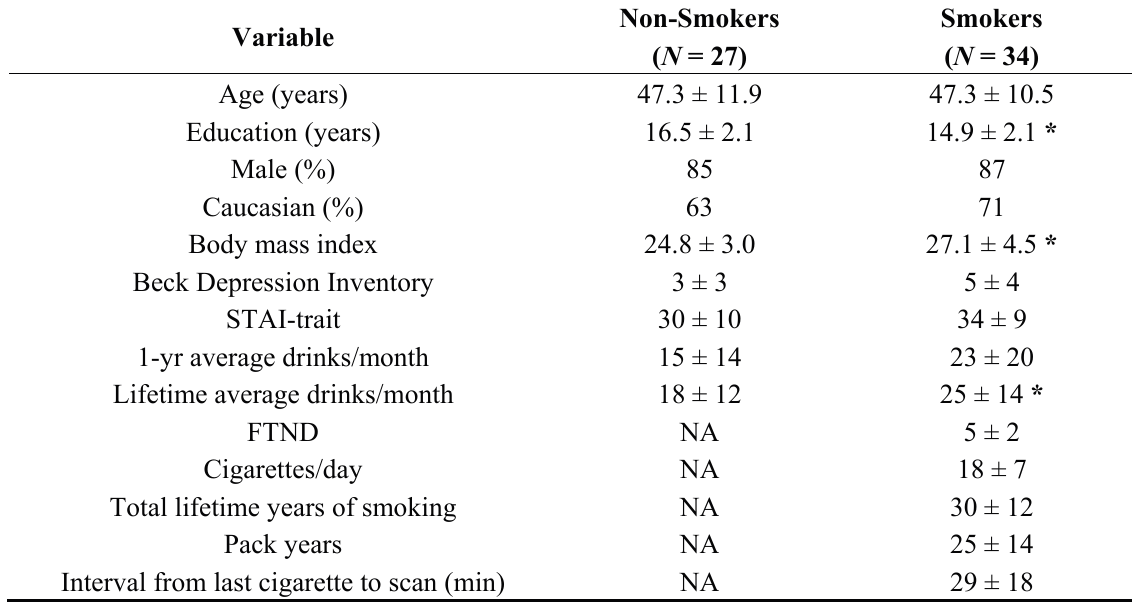
Table 1. Demographic and clinical